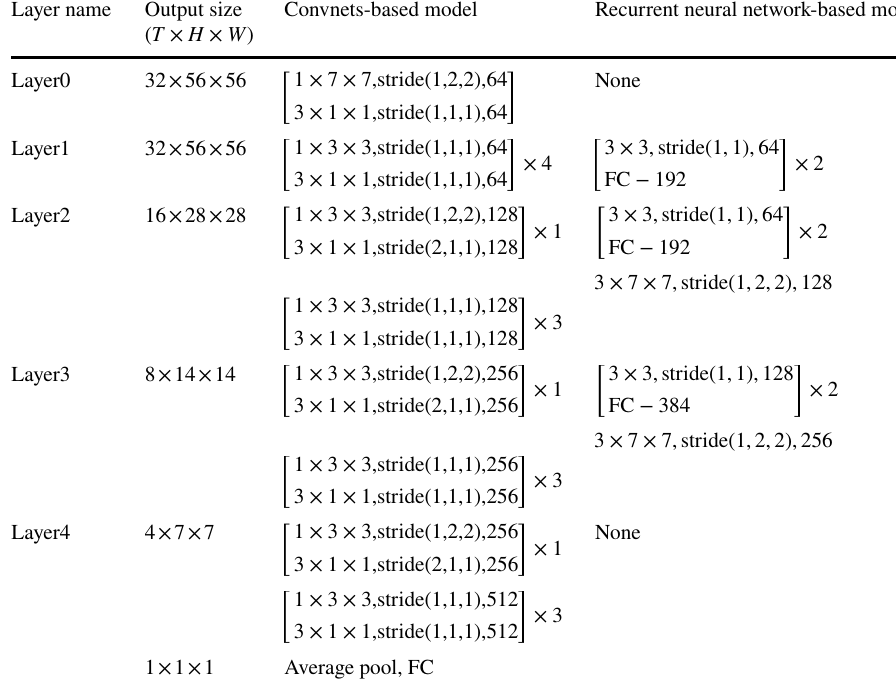
Table 1 The hyperparameters used in various components of our